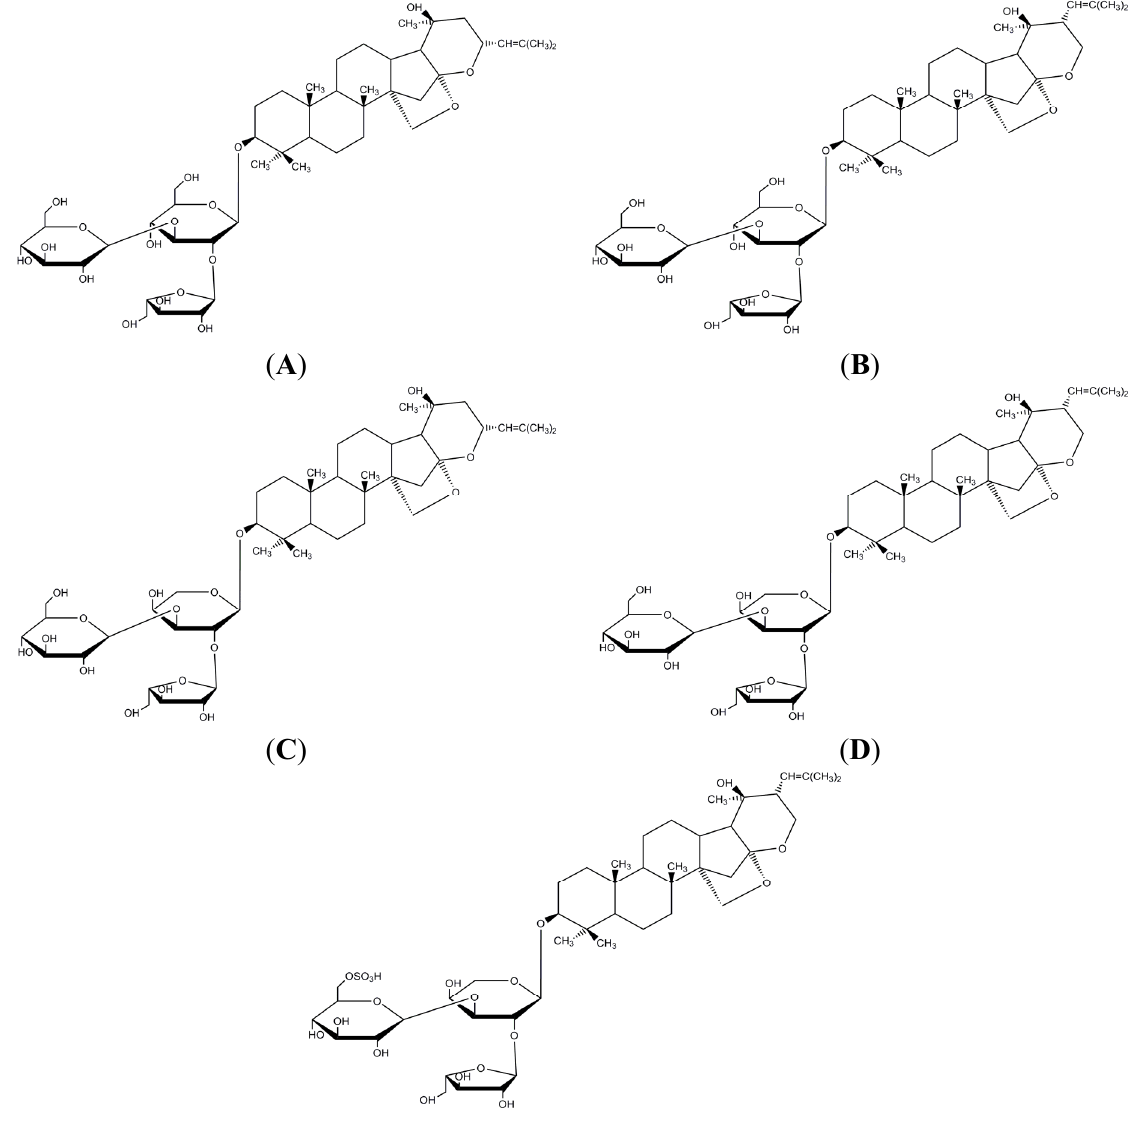
Figure 1. Structures of B. monnieri constituents, ( A ) bacoside A3; ( B ) bacopaside II; ( C ) bacopaside X; ( D ) bacopasaponin C and ( E ) bacopaside I. Bacoside A is a mixture of components A, B, C and D. These bacosides are dammarane-type triterpenoid saponins that have three sugar chains linked to a nonpolar triterpene aglycone